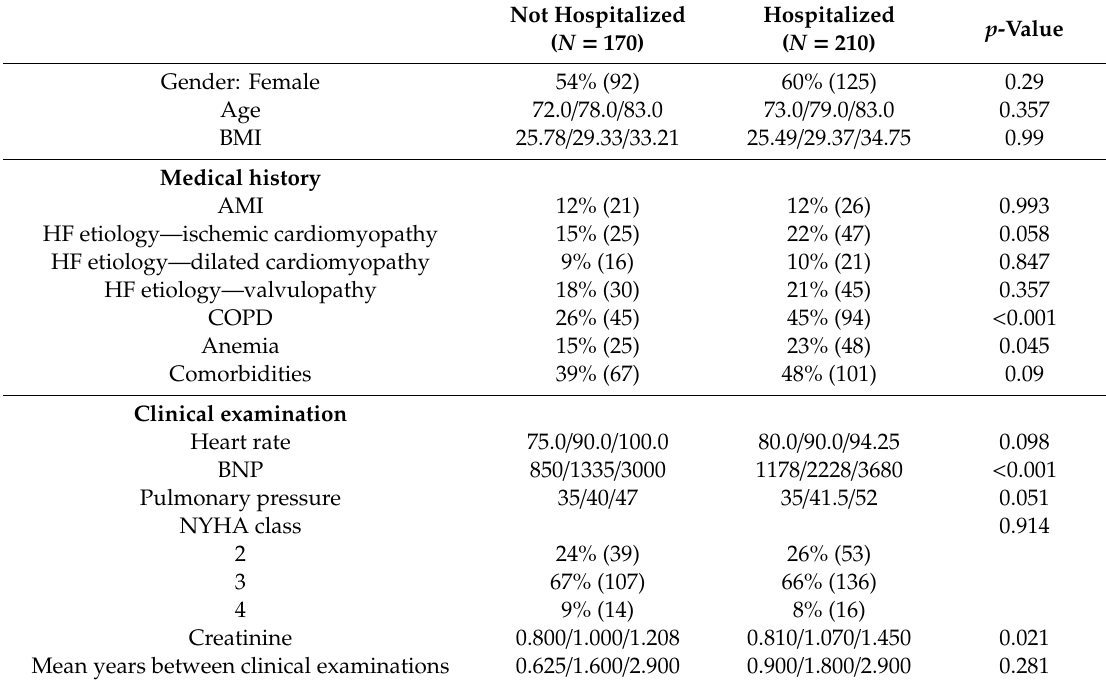
Table 1. Sample characteristics. Continuous data are reported as I quartile / Median / III quartile, categorical data are reported as percentage (absolute